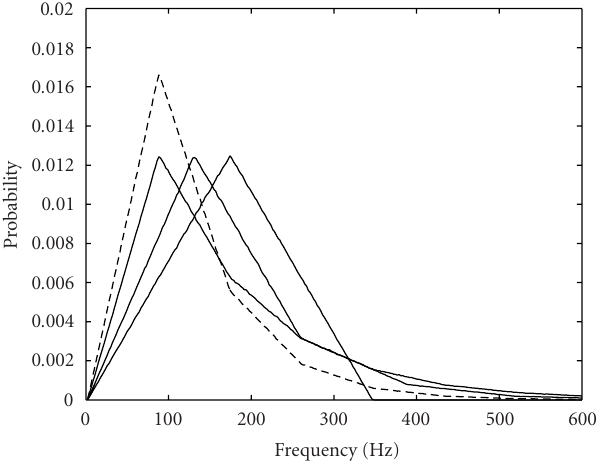
Figure 4: Experimental illustration ( ∆ F = F s / 2Hz) of the probability density function of the di ff erence between two successive frequencies in the cases of N = 128 and M = 128 (right), M = 171 (center), and M = 256 (left), and in the cases of N = 171 and M = 256 (dotted lines). The maximum is dF max = ∆ F/M (resp., 2, 3, and 4 bins, which are equivalent to 86Hz, 129Hz, and 172Hz). Only the curve corresponding to the case N = M is symmetric.